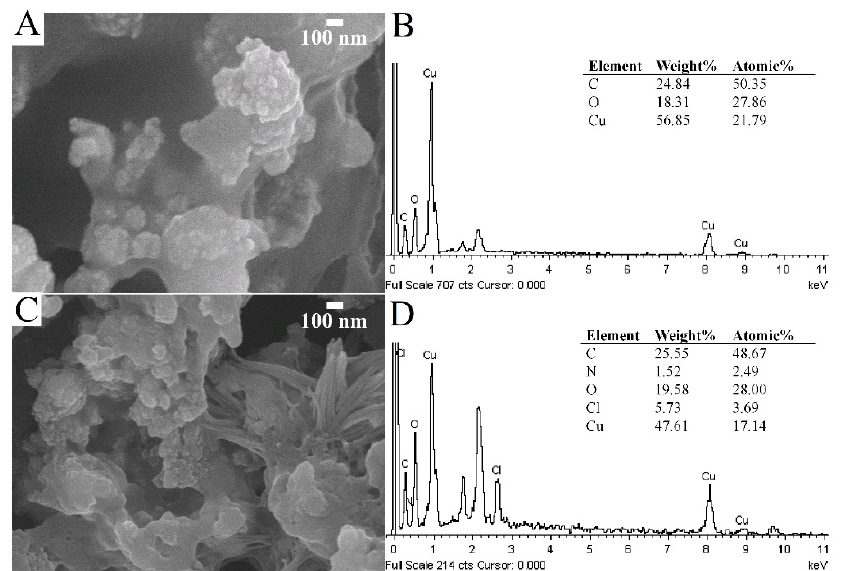
Figure 4. Scanning electron microscopy image ( A ) and its corresponding energy dispersive Spectrometry spectrum ( B ) of the CuO-C-dots on SPCE, and scanning electron microscopy image ( C ), and its corresponding energy dispersive Spectrometry spectrum ( D ) of the PDDA/CuO-C-dots on SPCE.